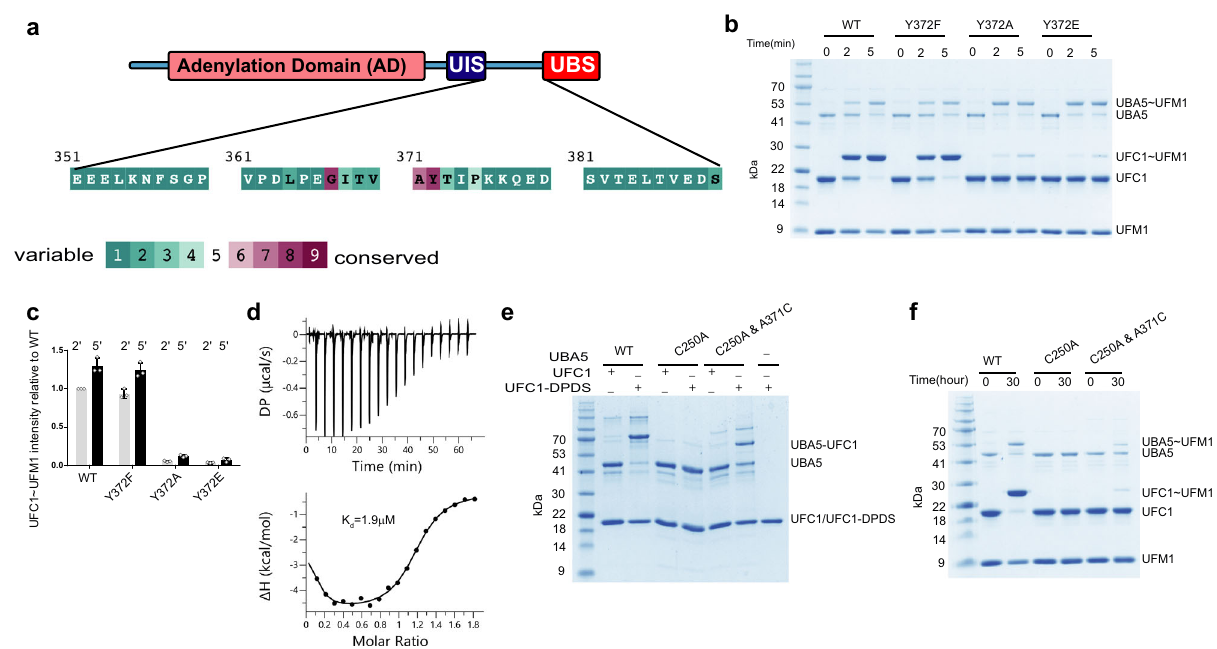
Fig. 4 Characterization of UBA5 linker. a ConSeq evolutionary conservation analysis of UBA5(351 – 390). b SDS – PAGE analysis showing the effect of Y372 mutations on the transfer of UFM1 to UFC1. c Three independent experiments as shown in b were performed to quantify the effect of the indicated mutations on UFM1 transfer. Data are represented by mean ± SD. d ITC experiment of UFC1 binding to UBA5 Y372A. The top graph represents raw data of heat fl ow versus time. The area under the peaks of the upper panel was integrated and plotted as kcal per mole of UFC1 as a function of binding stoichiometry in the bottom panel. Thermodynamic parameters are summarized in Supplementary Table 2. e UBA5 WT or mutants were incubated with UFC1 that was activated with DPDS and then were subjected to SDS PAGE analysis for UBA5-UFC1 adduct formation. The gel is representative of two independent experiments. f UBA5 WT or mutants were incubated with WT UFC1 and UFM1 then subjected to SDS – PAGE analysis for the formation of UFM1 charged UFC1. The gel is representative of two independent